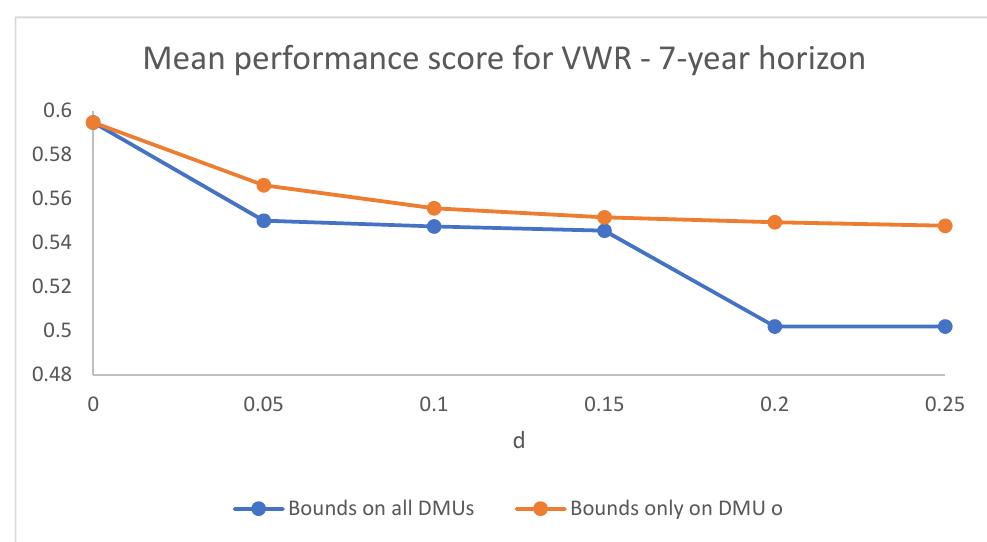
Figure 2. Comparison of the dynamics of the mean performance scores of VW restrictions in the cases with constraints on all DMUs and only on the target DMU as d increases, for T = 7 and symmetric